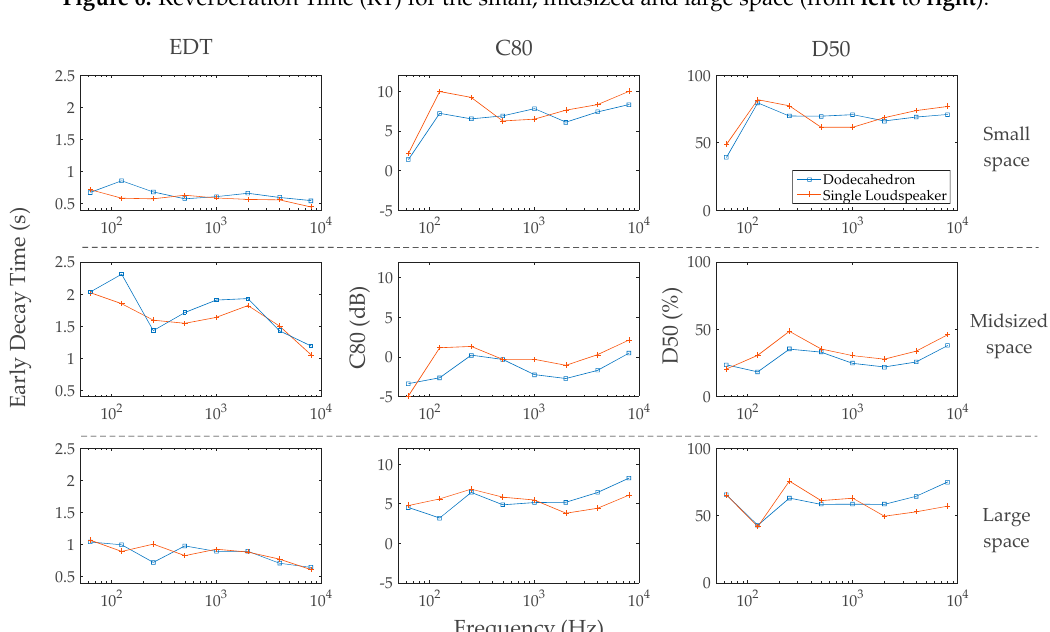
Figure 7. Early Decay Time (EDT), Clarity (C 80 ) and Definition (D 50 ) for the small, midsized and large space. Table 1. Mean Absolute Error (M.A.E.), Standard Deviation (S.D.) and Relative Error (R.E.) of RT, EDT, C 80 and D 50 for measurements with a directional speaker compared with measurements with the dodecahedron speaker for the small, midsized and large space.